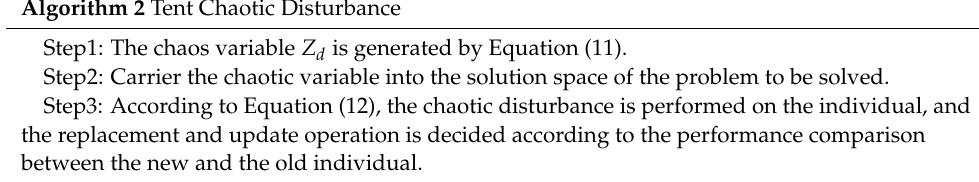
Algorithm 2 Tent Chaotic